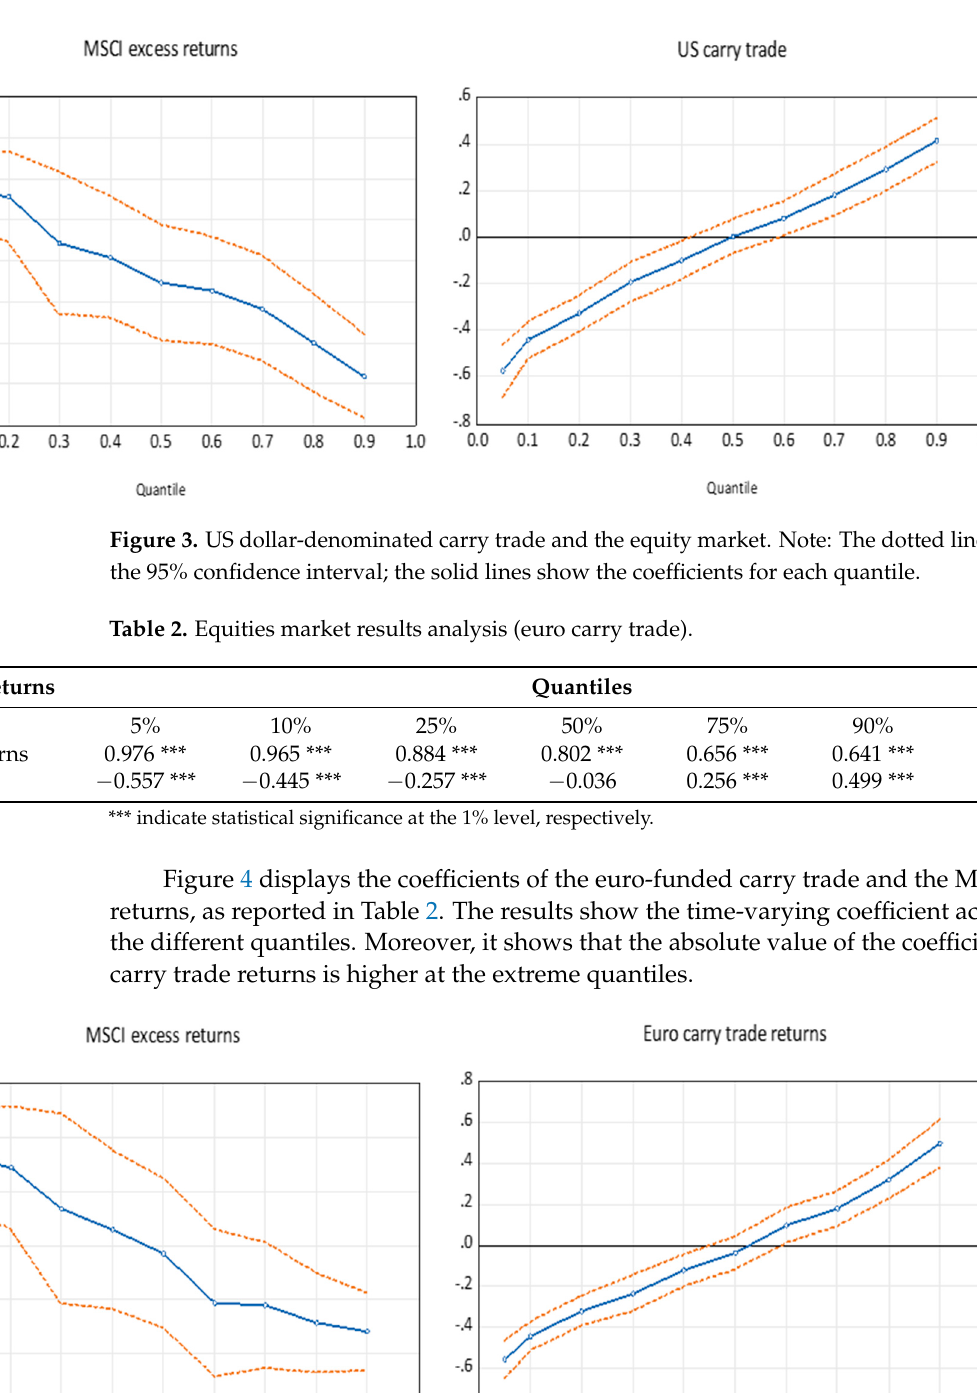
Figure 4. Euro-denominated carry trade and the equity market. Note: The dotted line represents the 95% confidence interval; the solid lines show the coefficients for each quantile.